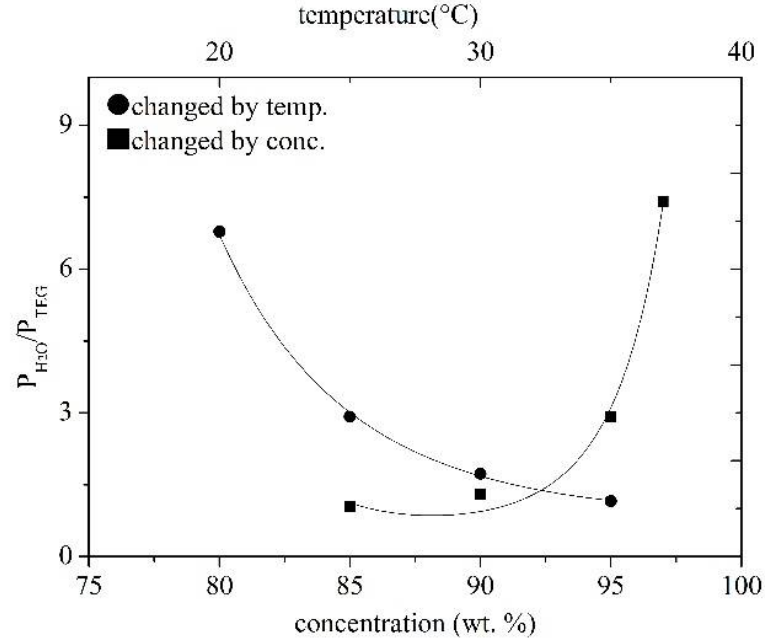
Figure 7. Effects of concentration and temperature of the TEG solution on the ratio of the partial pressure of water vapor to the vapor pressure of the TEG solution.